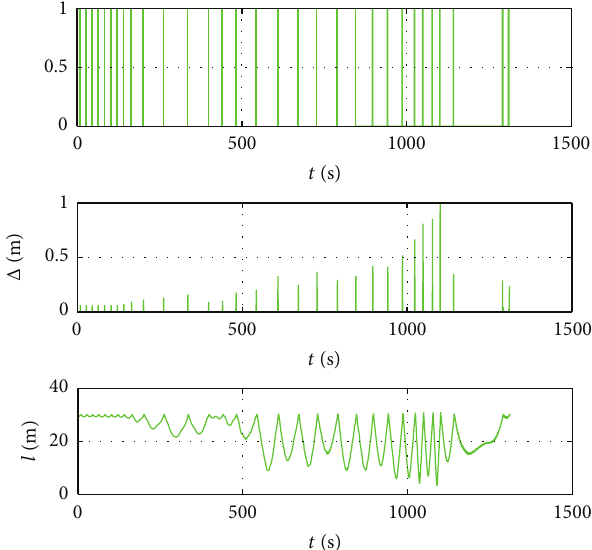
Figure 22: The tensional and tensionless states, the elongation of the tether, and the distance between the two spacecraft.